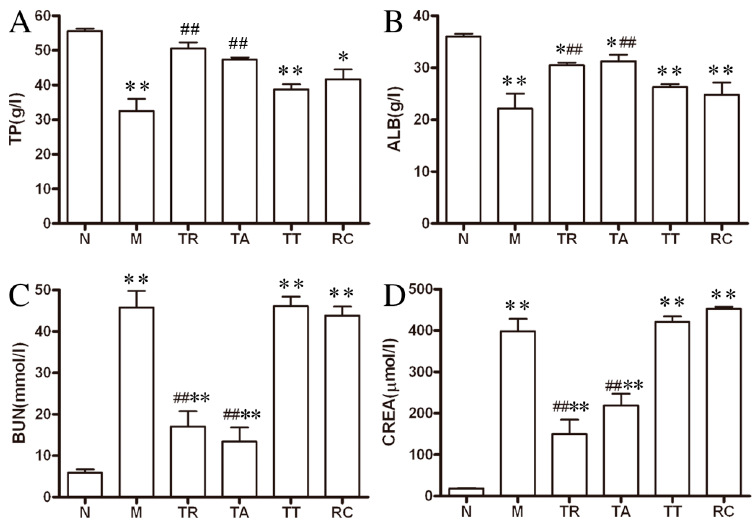
Figure 3. Compared to the HgCl 2 alone group, blood serum urea nitrogen (BUN) and creatinine (CREA) values of rats were significantly lowered both in the total extract of rhubarb and the total anthraquinones-treated groups ( p < 0.01) and the level of total protein (TP) and albumin (ALB) clearly increased ( p < 0.01) at the end of the experiment. ( A ) The level of TP in blood serum; ( B ) the level of ALB in blood serum; ( C ) the level of BUN in blood serum and ( D ) the level of CREA in blood serum. The data were presented as means ± SE of eight rats in each group.* p < 0.05, ** p < 0.01 vs. group N; ## p < 0.01 vs. group M.